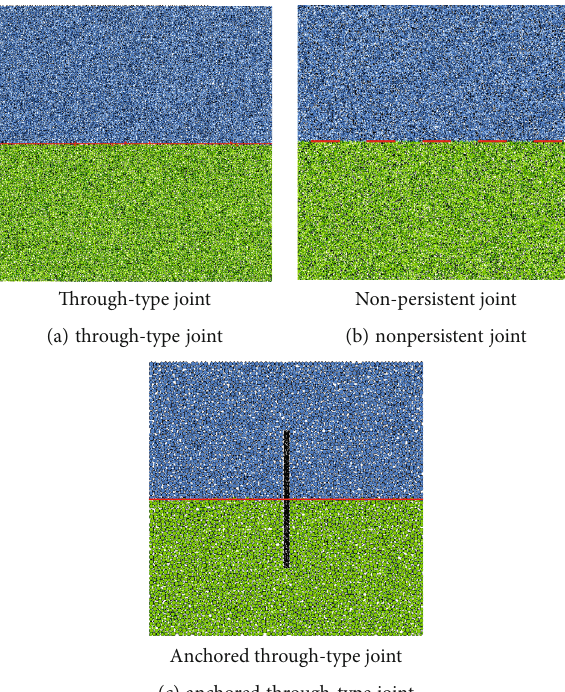
Figure 2: Diagrams of di ff erent joint models.